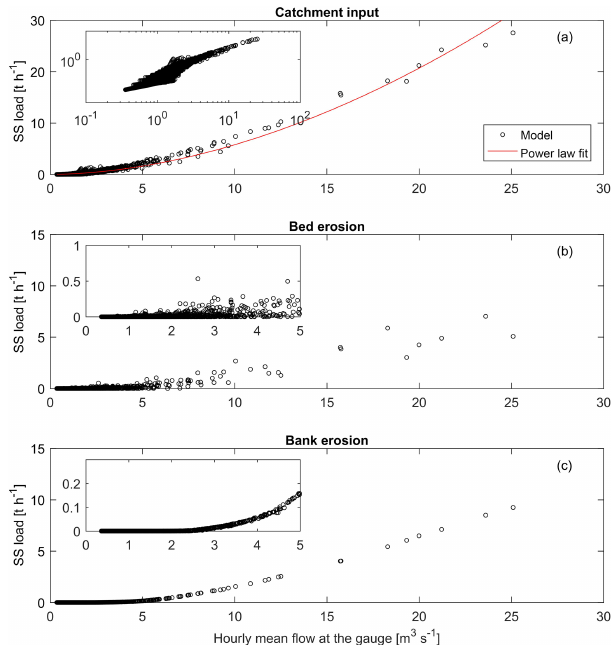
Figure 8. Relationship between simulated hourly mean flow and hourly suspended-sediment loads from the catchment (a) , bed ero- sion (b) , and bank erosion (c) , in which bed erosion and bank ero- sion are sums over all computation cells. Loads from the catchment are the sum of contributions from urban areas, nonurban areas, and the karst system.